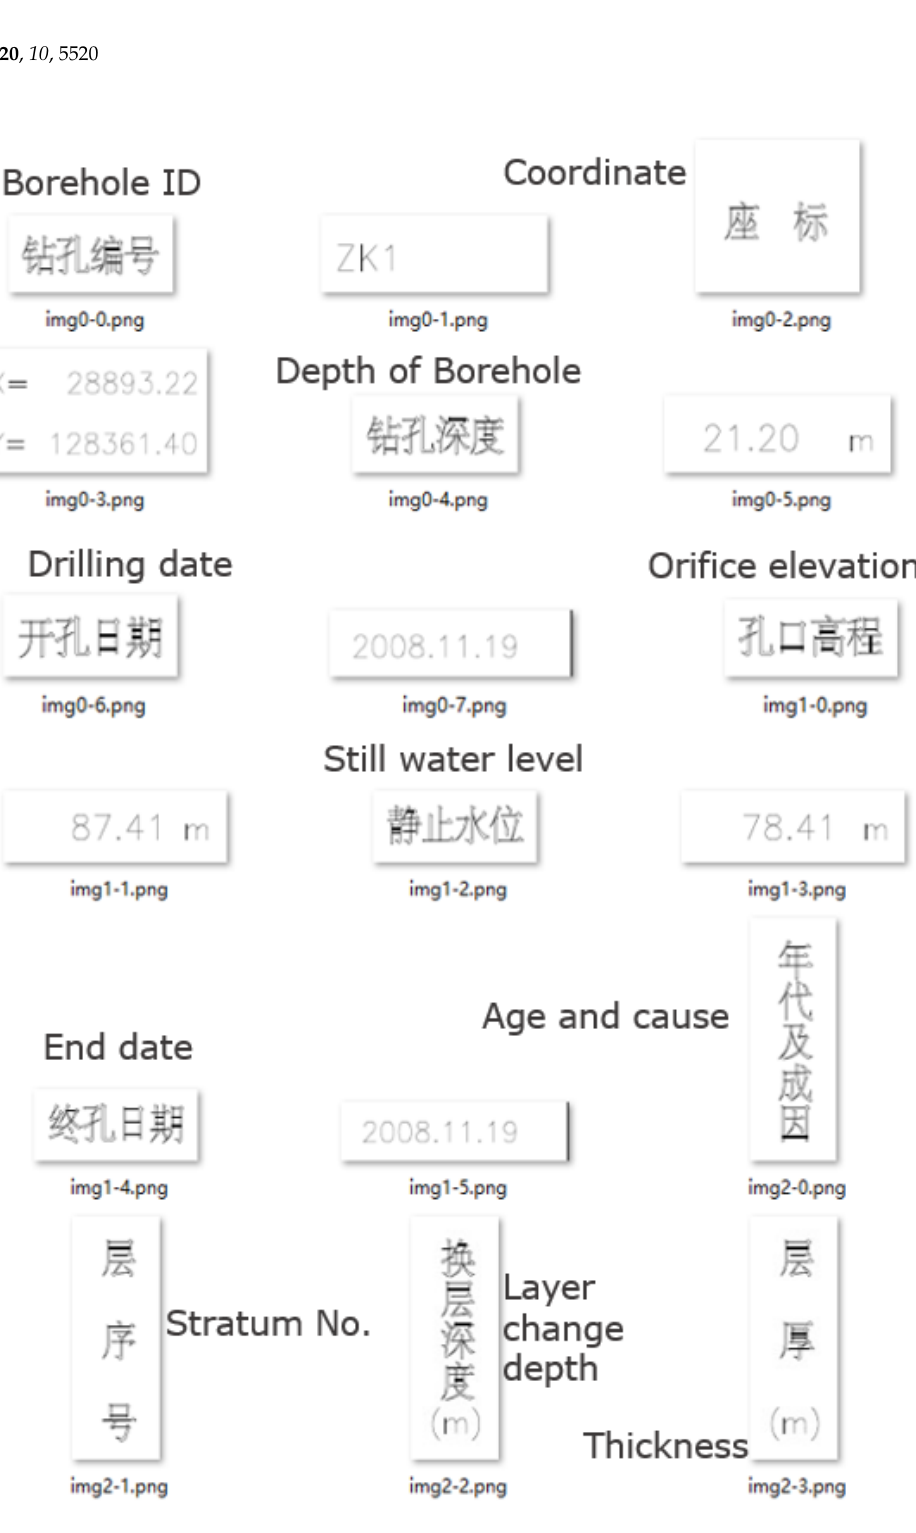
Figure 8. Segmentation results of the borehole